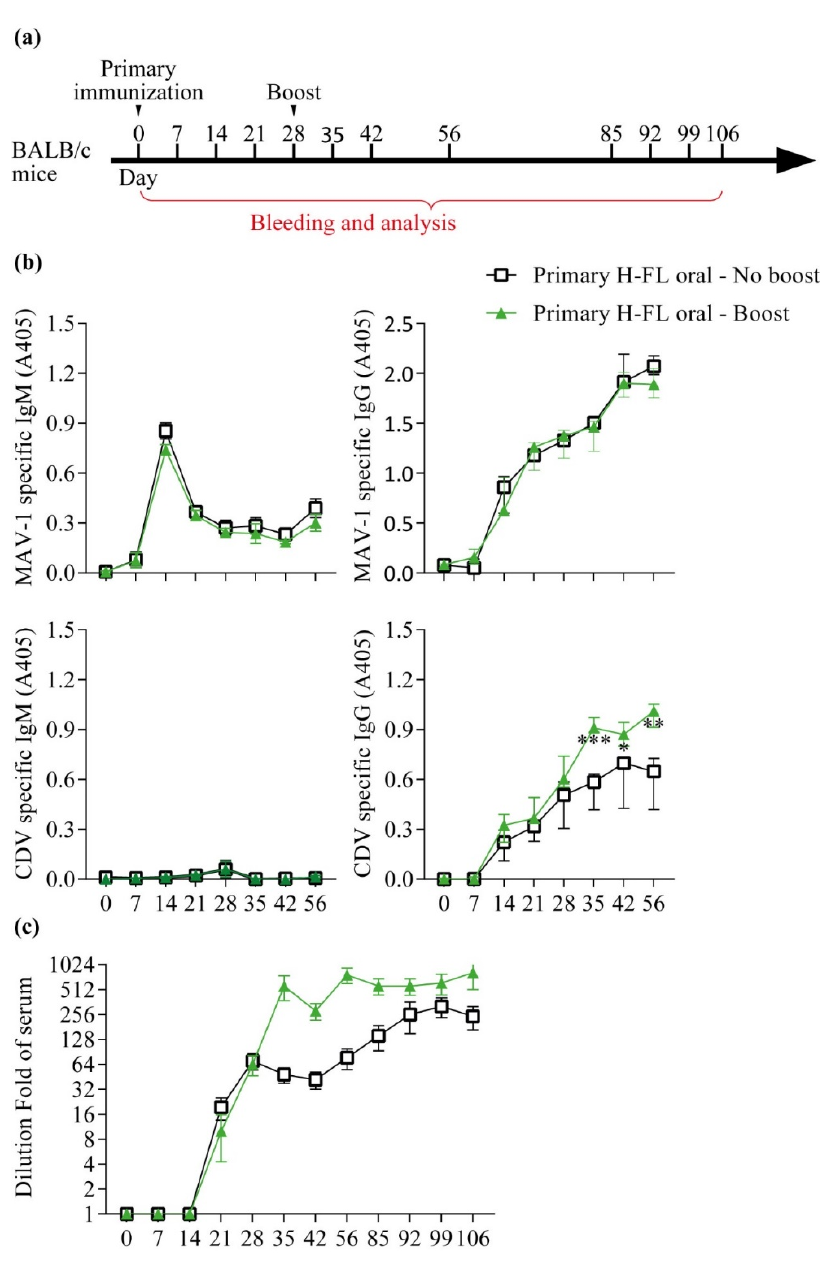
Figure 6. Boosting immune response with oral vaccination. ( a ) Design of the experiment. Eight- week-old female BALB/c mice ( n = 5 mice/group) were orally immunized with 2000 TCID50 of H-FL MAV-1 strain or with PBS as control (mock). Mice were then immunized, or not, with 2000 TCID50 of the H-FL MAV-1 strain at day 28 via the oral route. Blood samples were collected at the indicated times p.i. ( b ) MAV-1 and CDV specific IgG and IgM measured over time in mouse serum as described in the methods. The data presented are the means for 5 mice ± SEM. p values are relative to comparison with the mock group. *, p < 0.05, **, p < 0.01, ***, p < 0.001. ( c ) CDV-neutralizing antibody titres measured over time in mouse serum as described in the methods. The symbols and color code are identical to those in ( b ). The data presented are the means for 5 mice ±